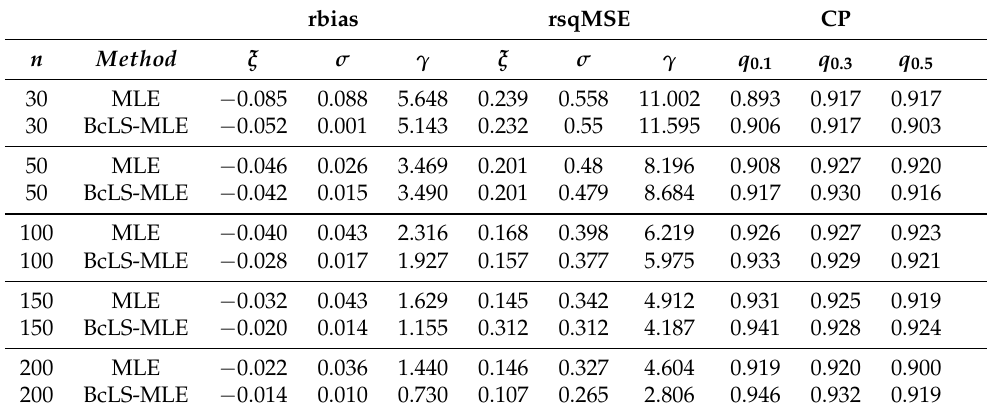
Table 2. The rbias and rsqMSEs of the BcLS-MLE and MLE, and the CP of S ( y 0 | Θ ) for LPN ( Θ ) with